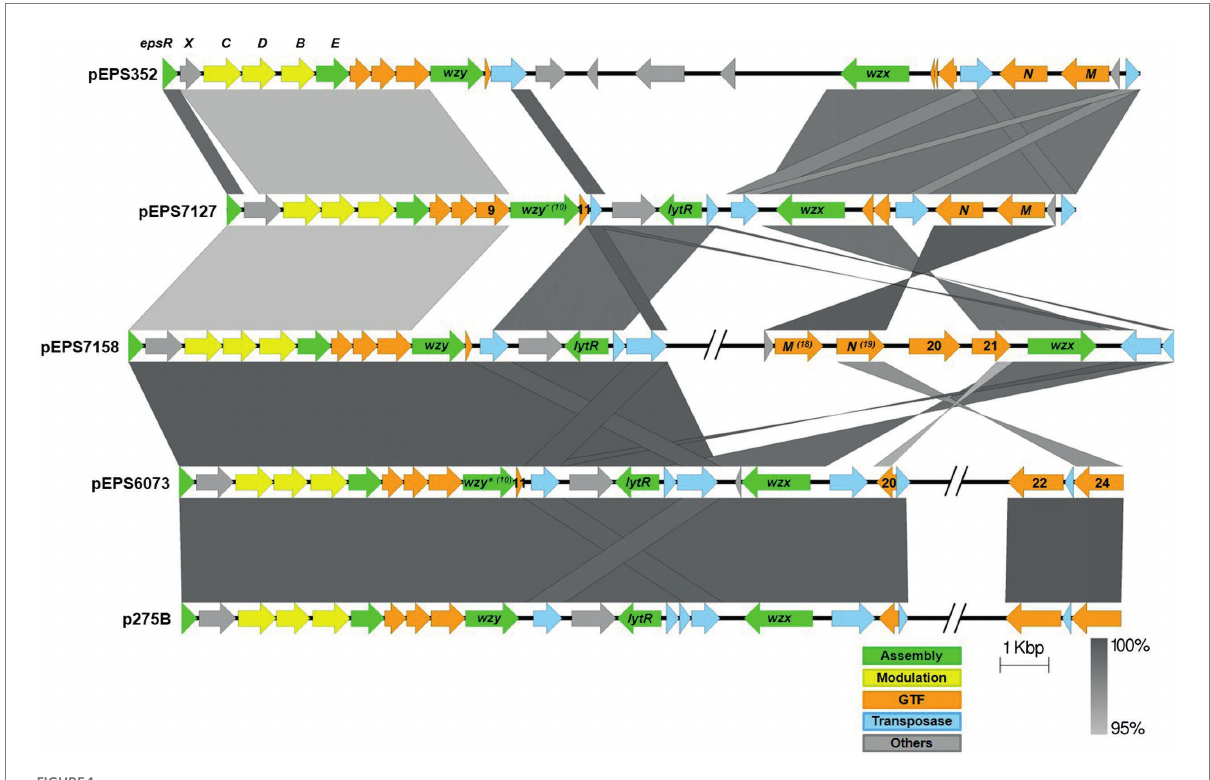
FIGURE 1 Lactococcal eps gene clusters. Comparison of IFF lactococcal eps gene clusters associated with P335 phage sensitivity and selected publicly available lactococcal eps gene clusters. 6073-like EPS is represented by pEPS6073 and pEPS7158 (EpsM variant). 7127-like EPS is represented by pEPS7127. Numbers appearing over gene depictions correspond to locus tags as annotated in sequences submitted to GenBank. Genes are colored based on their putative function, including EPS assembly, EPS modulation, glycosyltransferase, transposase, or others. The putative polymerase ( wzy ), flippase ( wzx ), and attachment ( lytR ) genes are annotated as such. *indicates designated signature genes. Gray bars are used to indicate sequence